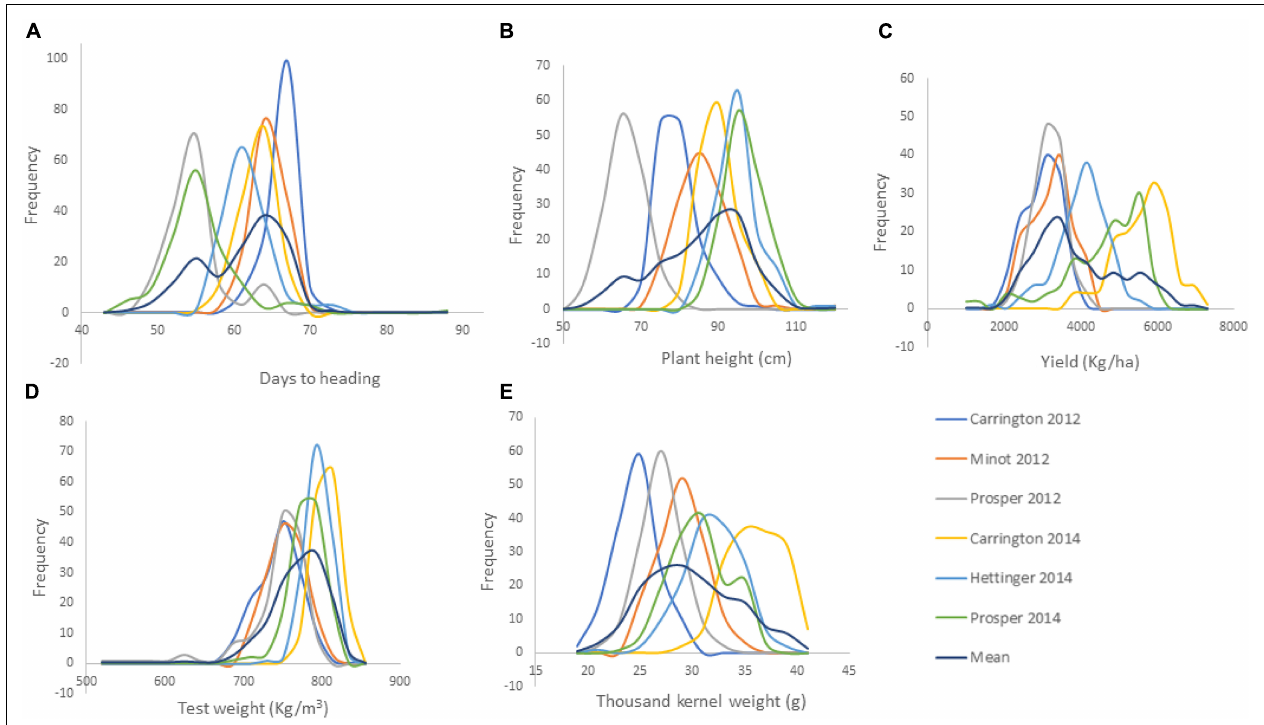
FIGURE 1 | Frequency distribution of the agronomic traits of 149 RILs of the cross of Reeder and Albany ( A. days to heading; B. plant height; C. yield; D. grain volume weight indicated here as test weight; and E. thousand kernel